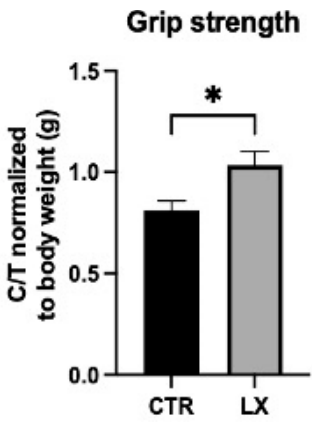
Figure 8. SPL Inhibition improves skeletal muscle function. Grip strength of vehicle-treated (control, CTR) and LX2931-treated (LX) mdx pups at 6 weeks of age measured using a grip strength meter. C/T = compression/tension. Values are normalized to body weight in grams (g). Mean ± SD; * p < 0.05; n = 8–10/group.